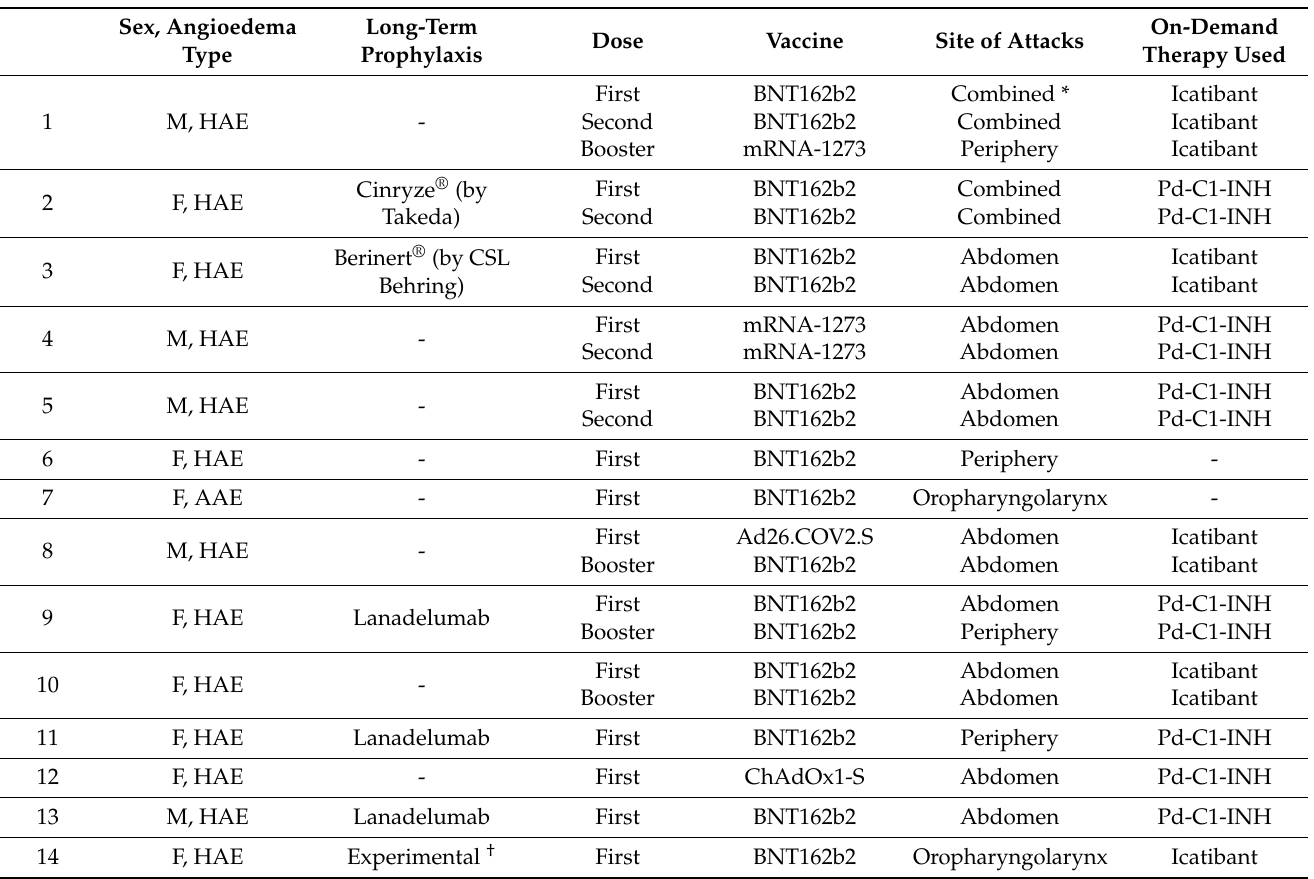
Table 7. Characteristics of the patients who developed an angioedema attack following the